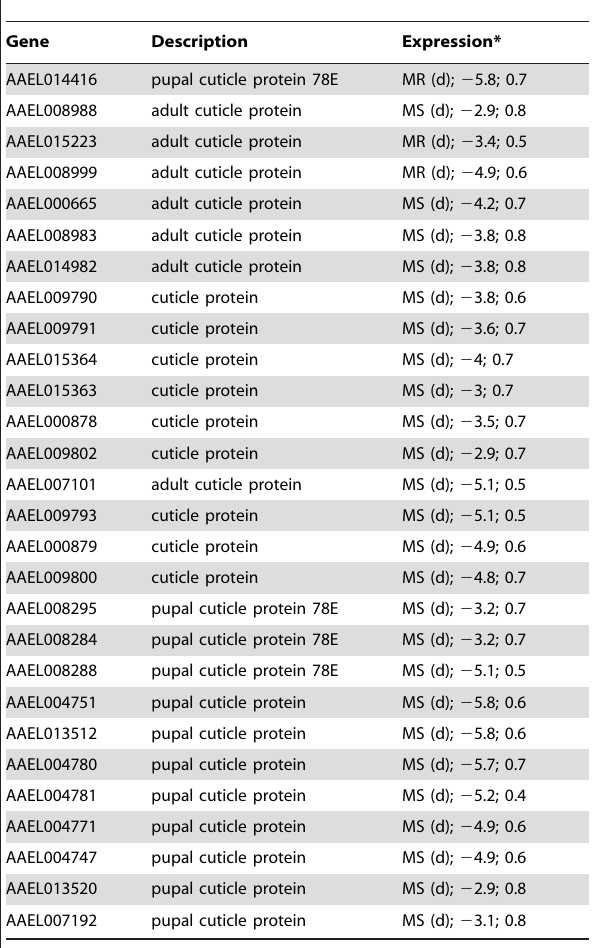
Table 5. List of V-ATPase genes. Gene